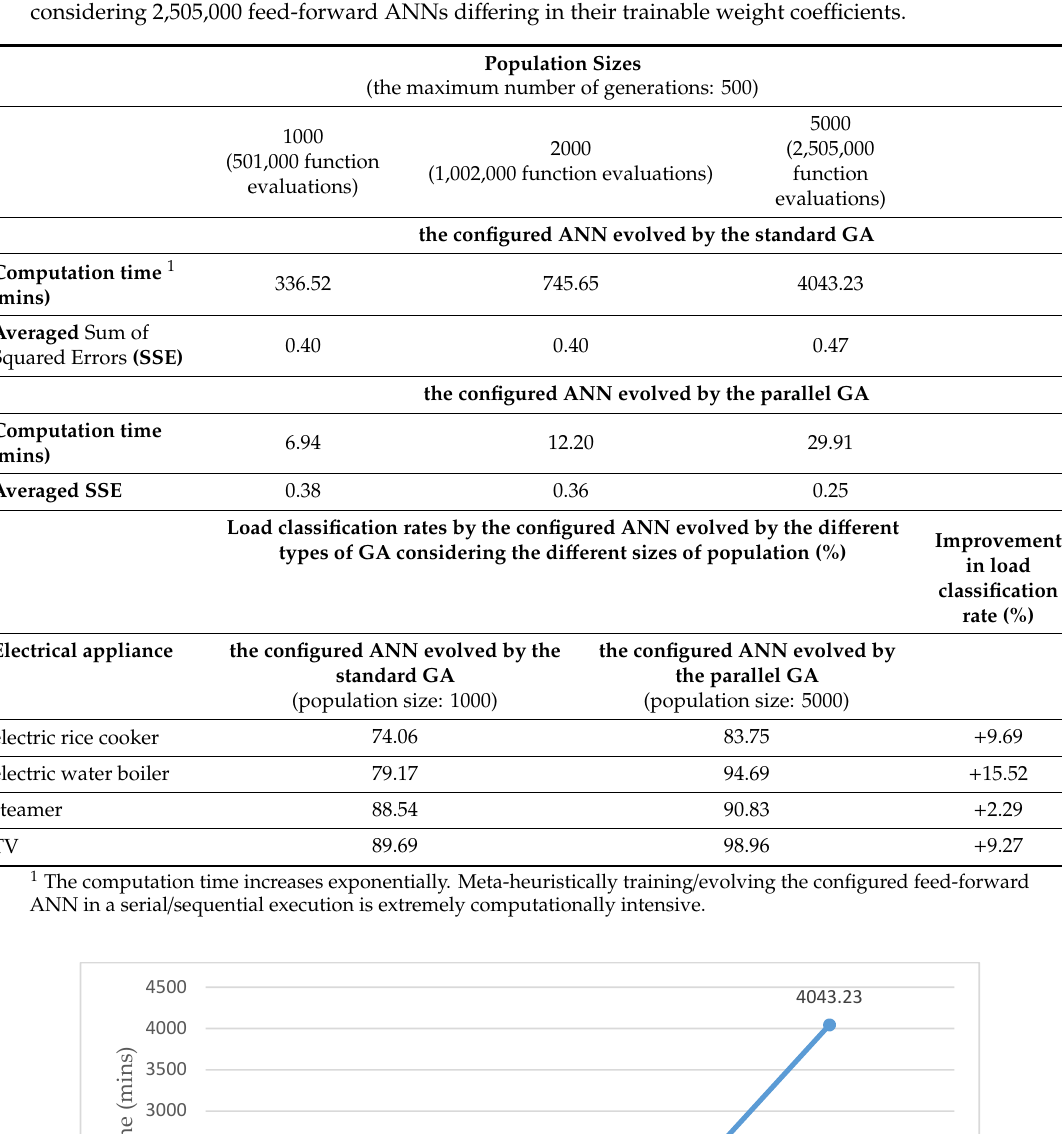
Table 2. Improved load classification rates by the parallel GA-embodied ANN, in this experiment,